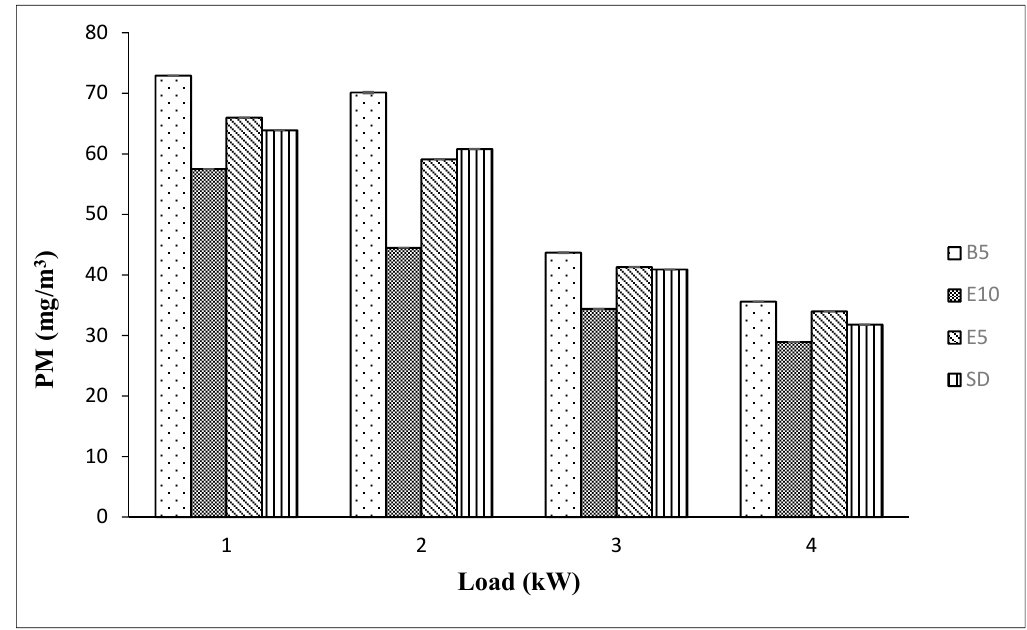
Figure 19. Concentration of PM for B5, E10, E5, and SD under different load conditions.